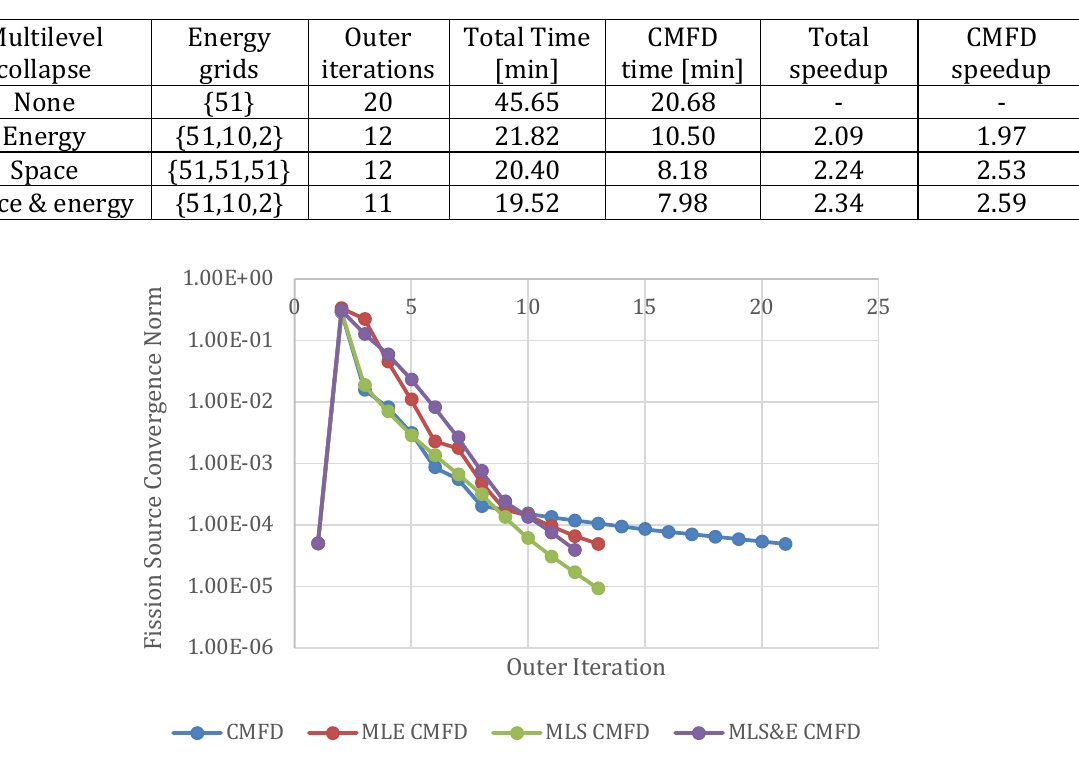
Figure 4. Convergence behavior of fission source for the CMFD solvers for Problem